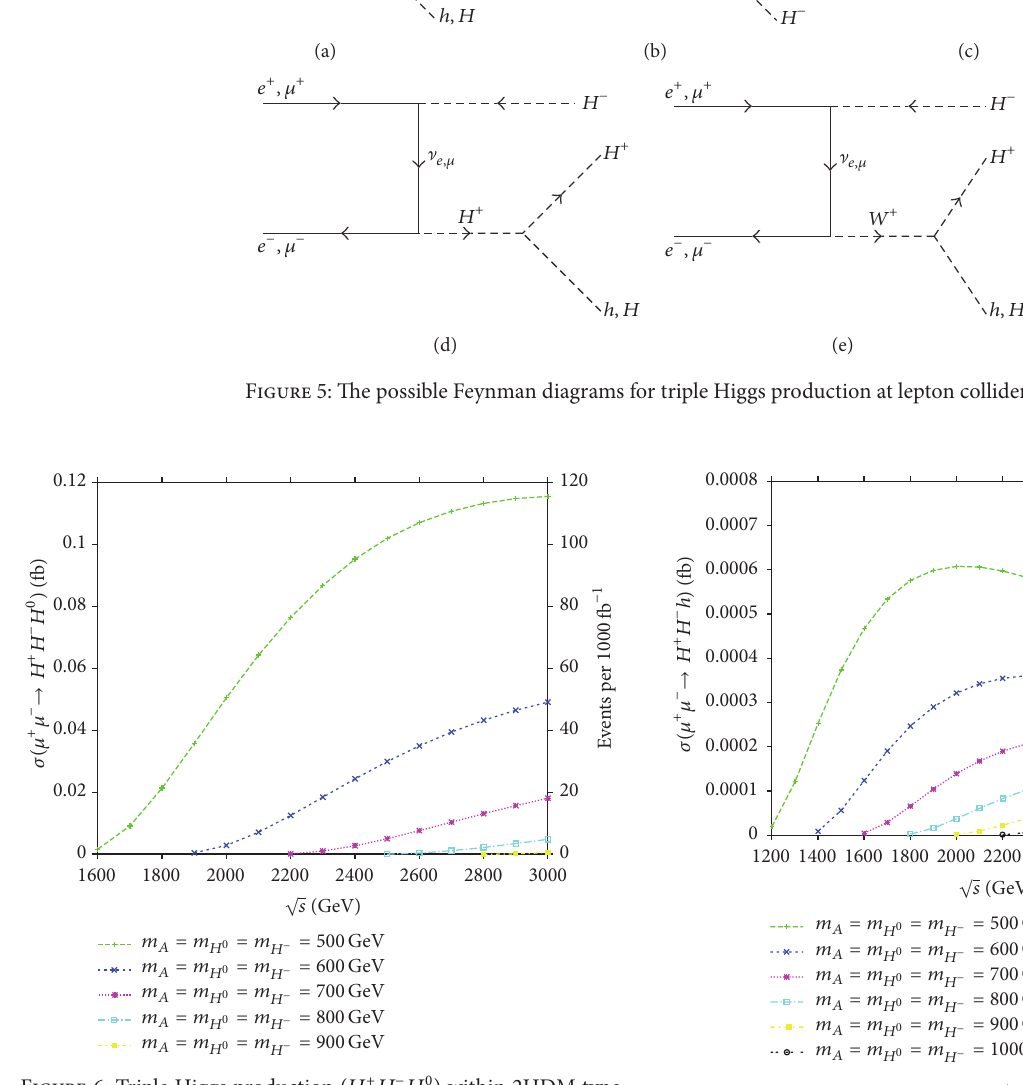
Figure 7: Triple Higgs production ( 𝐻 + 𝐻 − ℎ 0 ) within 2HDM type II for various 𝑚 𝐻 ± values. Neutral Higgs bosons have masses equal to the mass of the charged